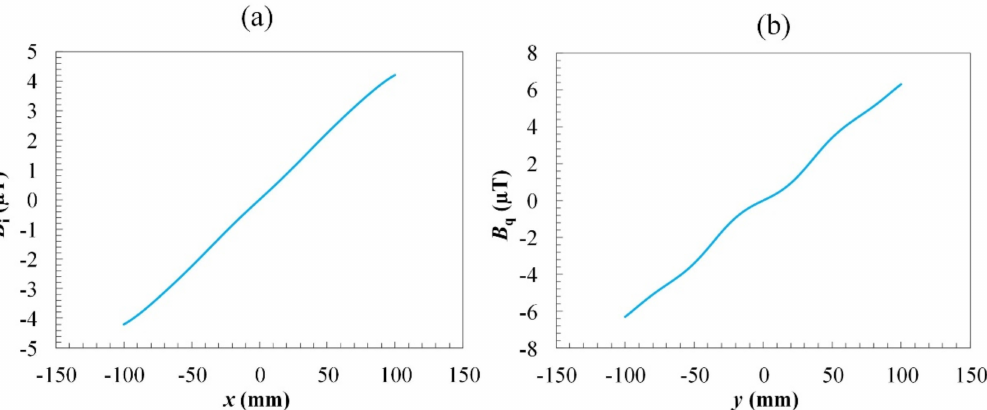
Figure 4. The calculated field distribution with the excitation current of 4.28 mA of ( a ) x -coil ( B i ) at y = 0 and ( b ) y -coil ( B q ) at x =